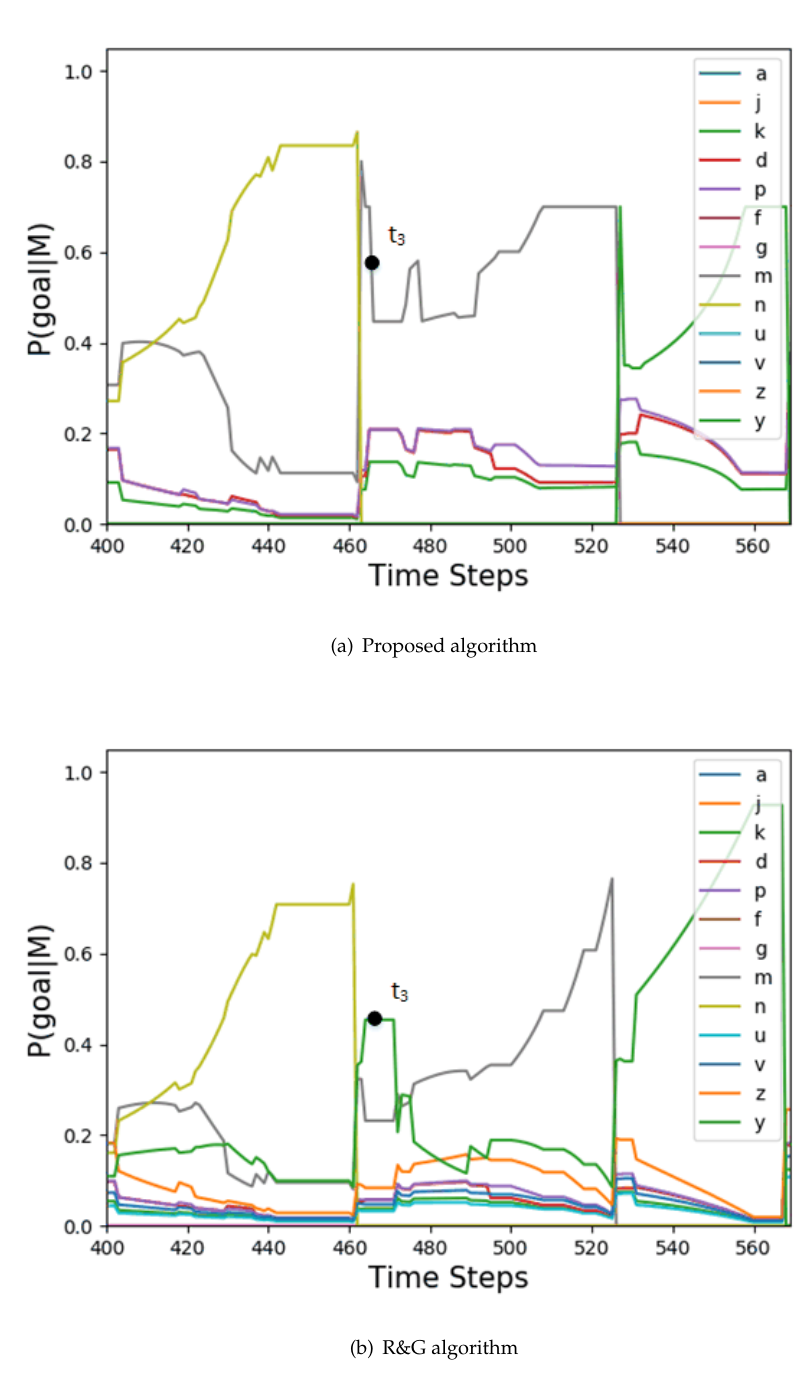
Figure 6. The goal probability curves of agent